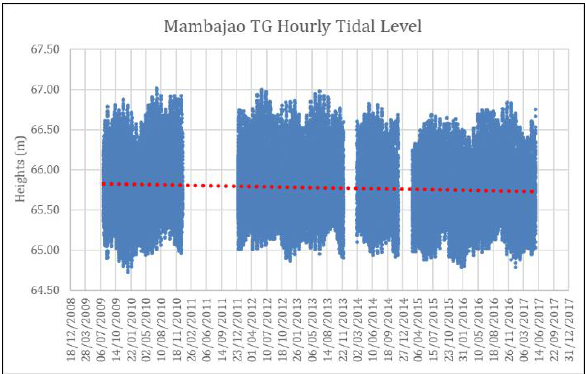
Figure 4. Mambajao TG hourly tidal